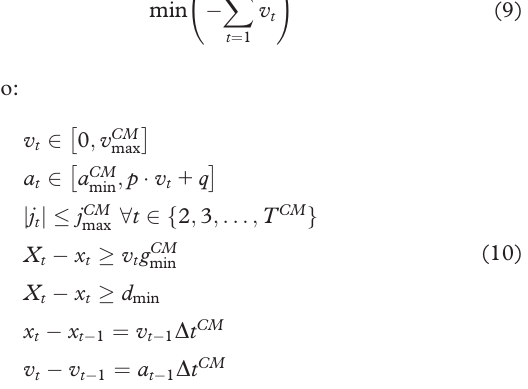
Figure 4 Merging scenario of multilane